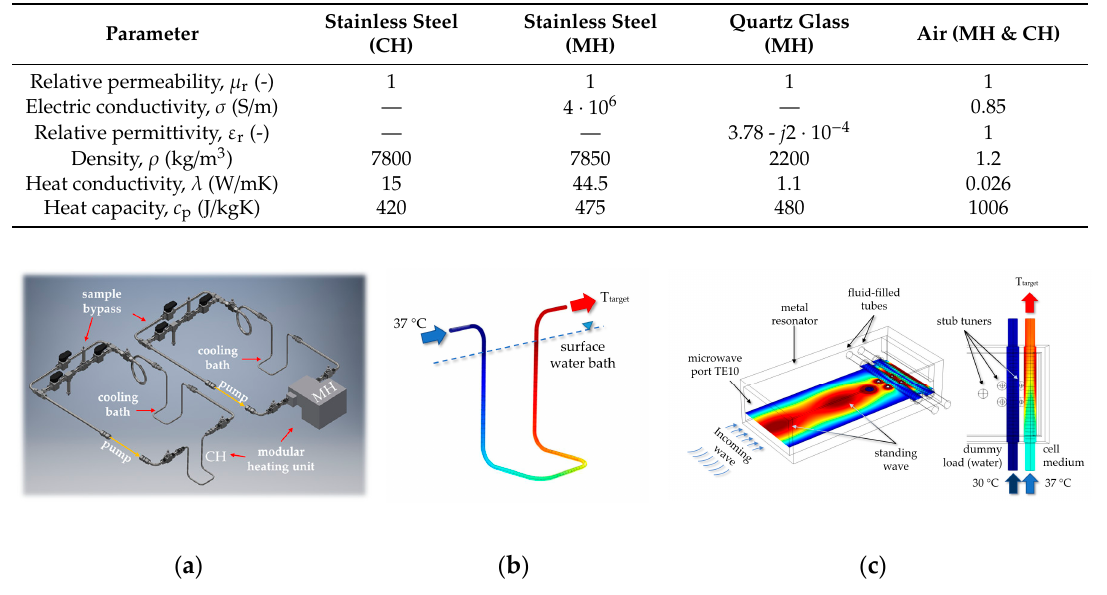
Figure 16. ( a ) CAD drawing of the closed-loop heating system with regions of interest, i.e., modular heating unit CH or MH (see also Figure 14 and ( b ) conventional warm-water and ( c ) microwave heating model for numerical simulations and modeling.